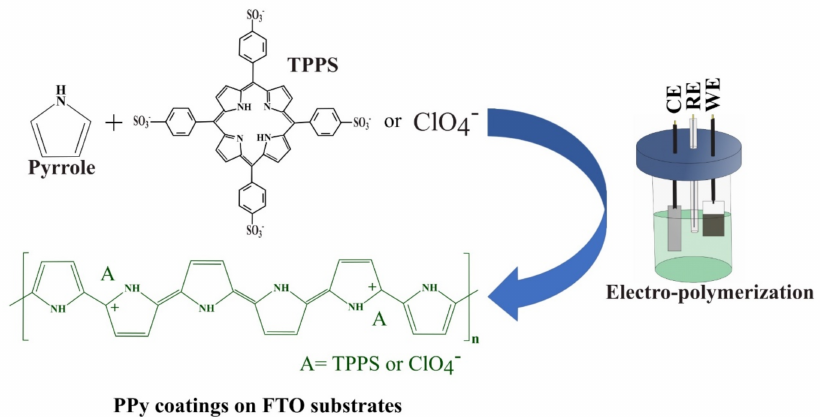
Figure 1. Schematic illustration of the electrochemical synthesis of meso-tetra-(4-sulfonatophenyl)- porphin (TPPS)-doped polypyrrole (PPy) and ClO 4 − -doped PPy. (CE: counter-electrode, RE: refer- ence electrode, WE: working electrode: fluorine doped tin oxide